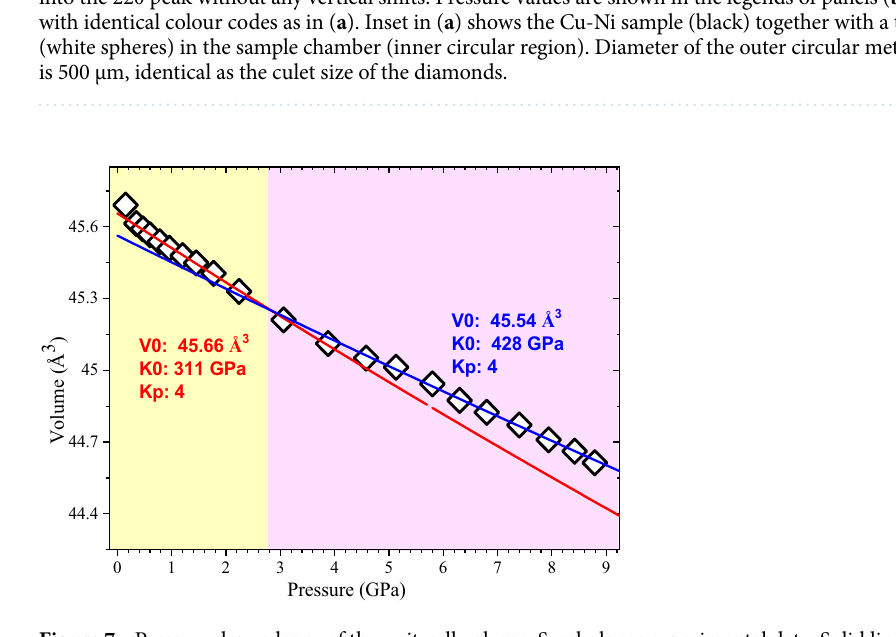
Figure 7. Pressure dependence of the unit-cell volume. Symbols are experimental data. Solid lines are fit to a second order Birch-Murnaghan equation. Obtained parameters of the equation of state (E 0 S–V 0 is extrapolated zero pressure unit-cell volume. K is the bulk modulus; Kp is the pressure derivative of K) are also indicated. In the fit shown (solid lines) Kp is kept constant to